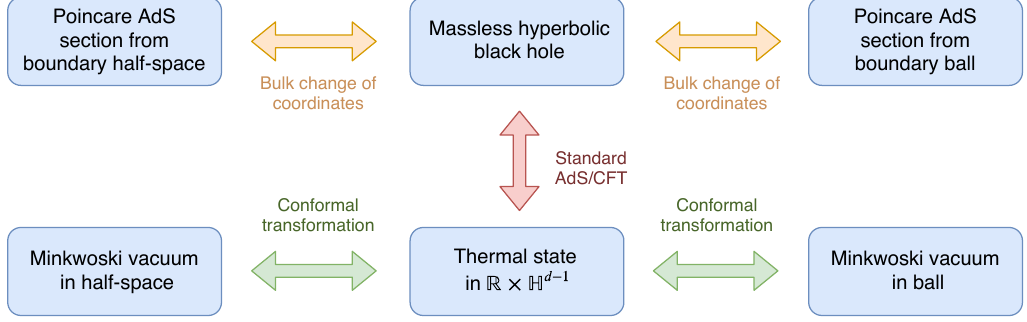
Figure 3 . Extension of the diagram in (cid:12)gure 2 for the case in which (cid:12) = 2 (cid:25)‘ with ‘ = (cid:11) or R , where the localized thermal states become equivalent to the Minkowski vacuum reduced to the region. The hyperbolic black hole becomes massless and can be mapped to a section of Poincare AdS determined from the ball or half-space boundary regions in